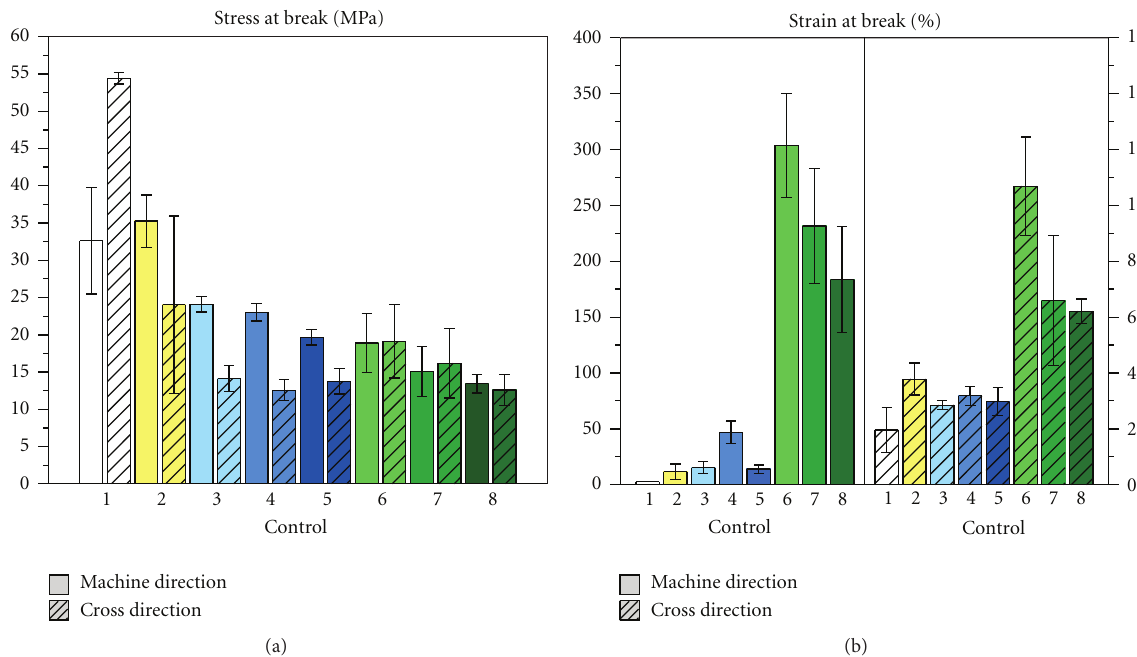
F 4: Stress at break and strain at break in machine and in cross